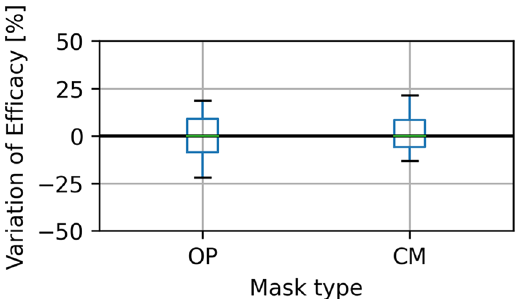
Figure 5. Variations between several masks from a single charge for surgical (OP) and community (CM) masks. The boxes show the Q1 to Q3 quartiles of the data, and the whiskers the maximum values. The variation is given in percentage points added to or subtracted from the mean efficacy of that mask type, so the doffing and donning of a fresh mask usually leads to a ± 10% absolute difference in the observed mask efficacy.